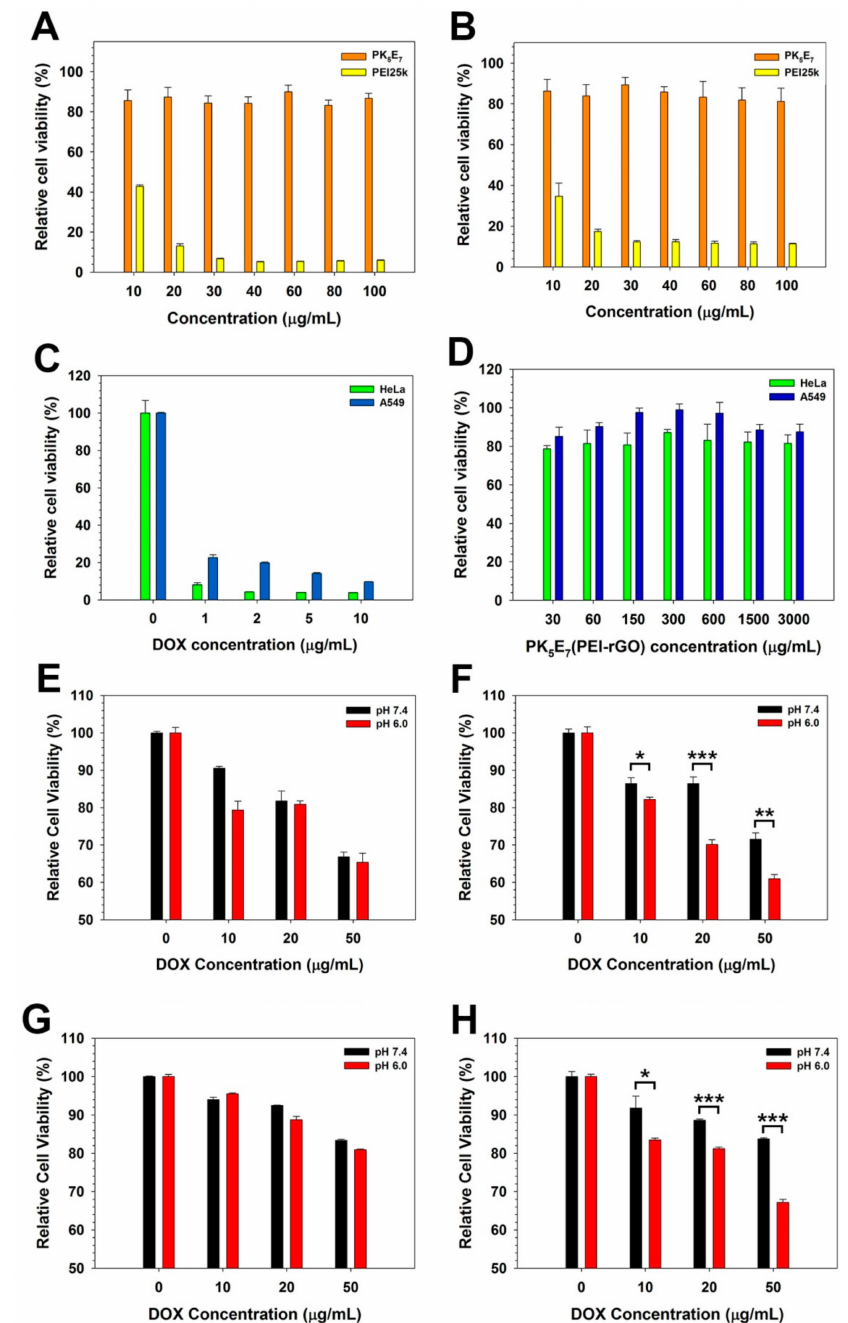
Figure 8. Cytotoxicity results of PK 5 E 7 in HeLa cells ( A ) and A549 cells ( B ). PEI25k was used as a control. Anticancer activity of DOX only in HeLa and A549 cells ( C ). Cytotoxicity results of DOX-unloaded PK 5 E 7 (PEI-rGO) in HeLa and A549 cells ( D ). Anticancer activity of PK 5 E 7 (PEI-rGO / DOX) in HeLa ( E , F ) and A549 cells ( G , H ). The experiments were conducted in serum-free ( E , G ) and serum (10% FBS) condition ( F , H ). Data are shown as the mean ± S.D ( n = 3) and statistically analyzed by t -test (* p < 0.05, ** p < 0.01, and *** p <